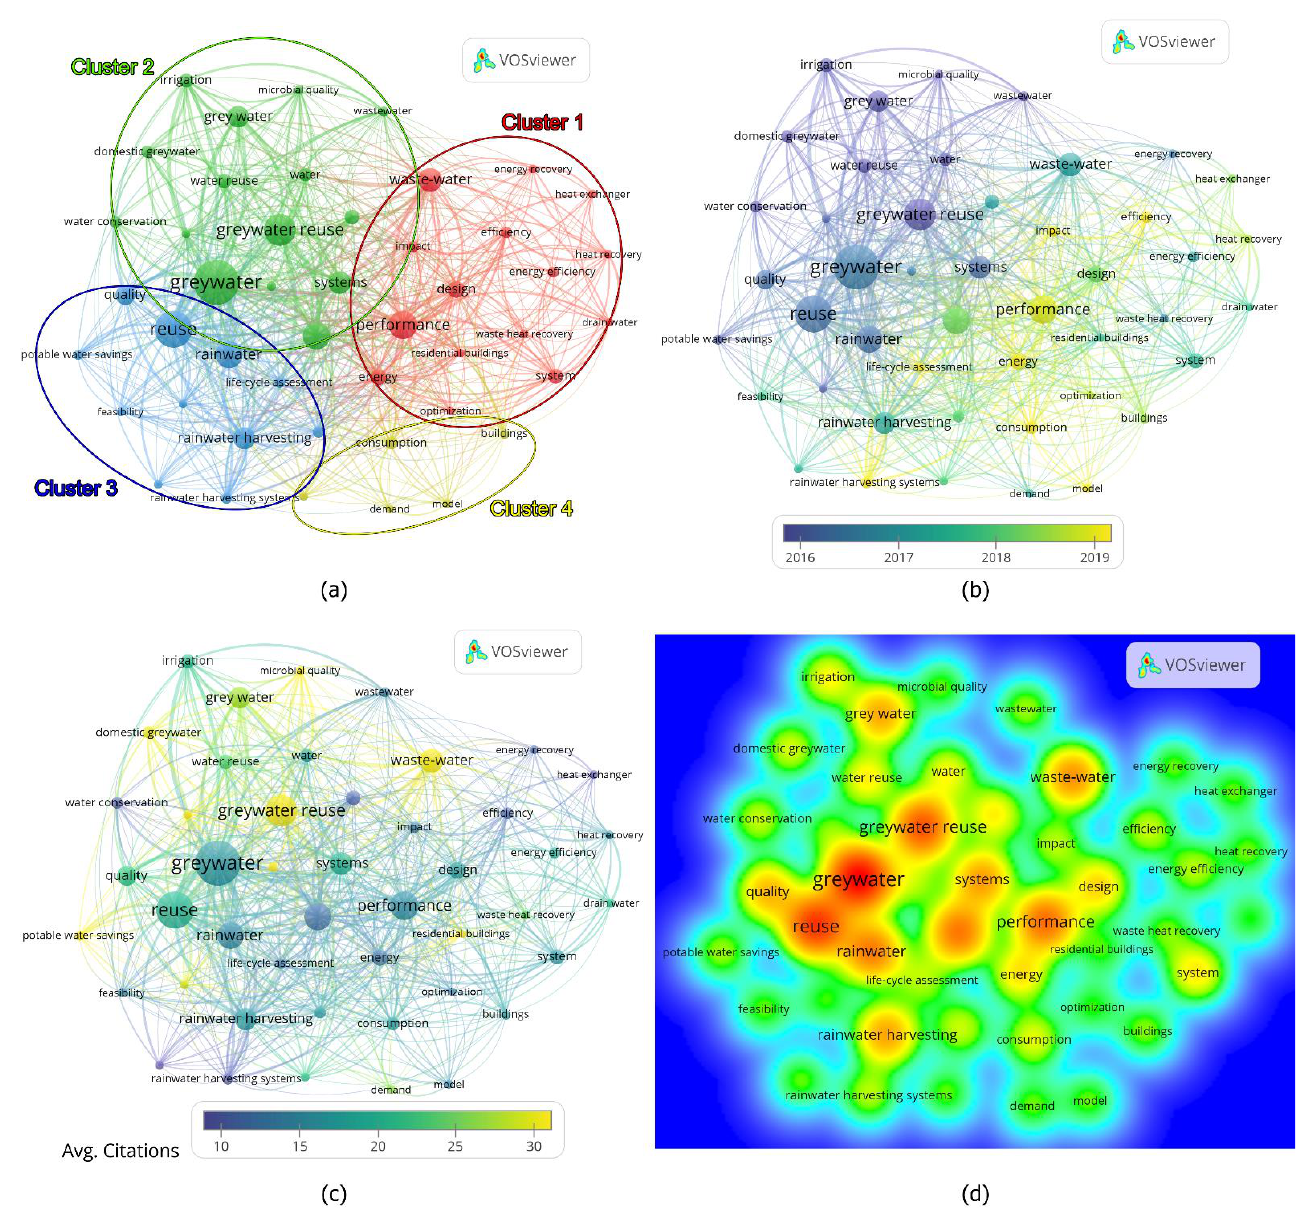
Figure 14. The keywords co-occurrence network of greywater recycling and heat recovery papers: ( a ) Clusters distributions; ( b ) Timeline of occurrences ( c ) Average number of citations; ( d ) Density view.